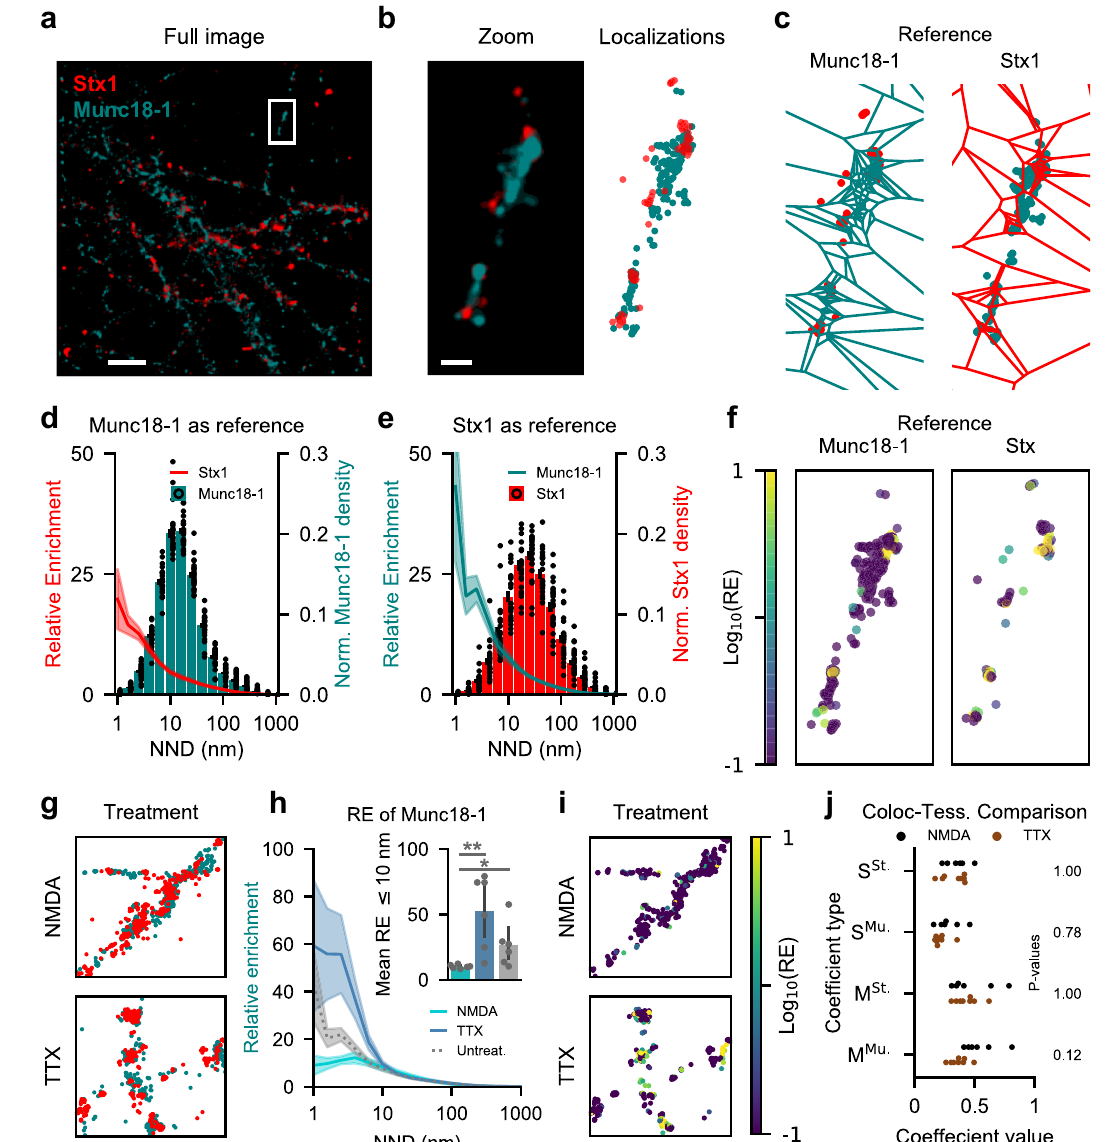
Fig. 3 | VisualisingREacrossdensitiesforlargerimages.a Representativeimage of Stx1 and Munc18-1 in primary hippocampal neurons acquired with dSTORM. Molecular localizations visualized by gaussian representation. Scale bar is 4 µ m. b Zoom on single varicosity from ( a ), with both Gaussian representation (left) and individual localizations (right). Scale bar is 400nm. c Voronoï-regions for tessel- lation of either Munc18-1 (left) or Stx1 (right). Individual localizations of opposite species are plotted beneath. Same scale as ( b ). d Munc18-1 regions binned by nearest neighbour distance, with mean Stx1 RE value for each bin as line plot. RE scoreon left-hand y-axis, and relative bindistributionon right-hand y-axis. Shaded area and black bars indicate S.E.M., n =8 images. e Same as ( d ), but with reference and primary species reversed. f Localizations of the reference species color-coded by RE score for Munc18-1 (left) and Stx1 (right). g Representative axons of